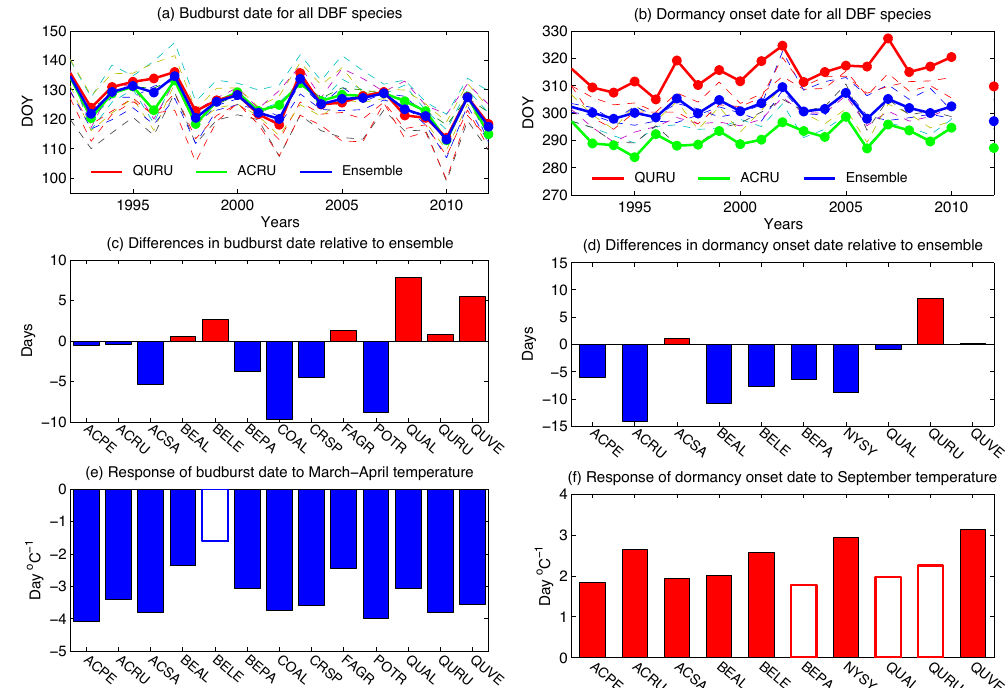
Figure 8. Interannual variations of phenological dates and their responses to temperature changes during 1992–2011 for each DBF species at Harvard Forest. The year-to-year (a) budburst and (b) dormancy onset dates are presented for species with observations available for at least 20 years. Values for red oak ( Quercus rubra , in red), red maple ( Acer rubrum , in green), and the ensemble average (in blue) based on basal area are highlighted in bold. The differences of species-specific dates relative to the ensembles are presented in (c) for budburst and (d) for dormancy onset. Temperature sensitivity of (e) budburst is calculated as the regressions between year-to-year budburst dates and March–April temperature. Similarly, regressions between dormancy onset dates and September temperature is calculated as the temperature sensitivity of (f) autumn phenology. For the middle and bottom panels, positive values are marked as red while negative ones are in blue. Significant ( p <0.05) temperature sensitivity in bottom panel is denoted with filled bar. Full names of species abbreviations are listed in Table S1, except for alternate-leaved dogwood ( Cornus alternifolia short as COAL) and Hawthorne ( Crataegus spp, abbreviated as CRSP).